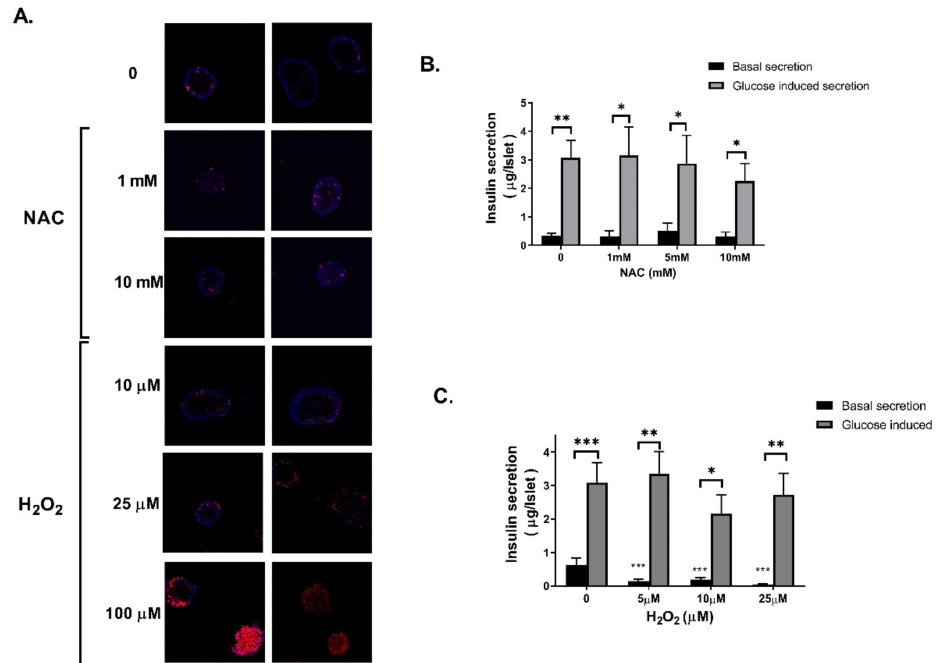
Figure 1. Effect of NAC on viability and functionality of pancreatic islets. Pancreatic islets were isolated from ICR mice and treated with NAC or H 2 O 2 for 24 h. Cytotoxicity was detected using PI staining. Hoechst staining indicates viable cells. Two representative micrographs are presented for each treatment ( A ). ( B , C ): Basal and glucose-induced insulin secretion were measured as described in Methods. The data represent the mean ± SEM of 5 independent experiments. * p < 0.05, ** p < 0.005 and *** p < 0.0005, compared to control, or as indicated, analyzed by two-way ANOVA, followed by Bonferroni’s post hoc